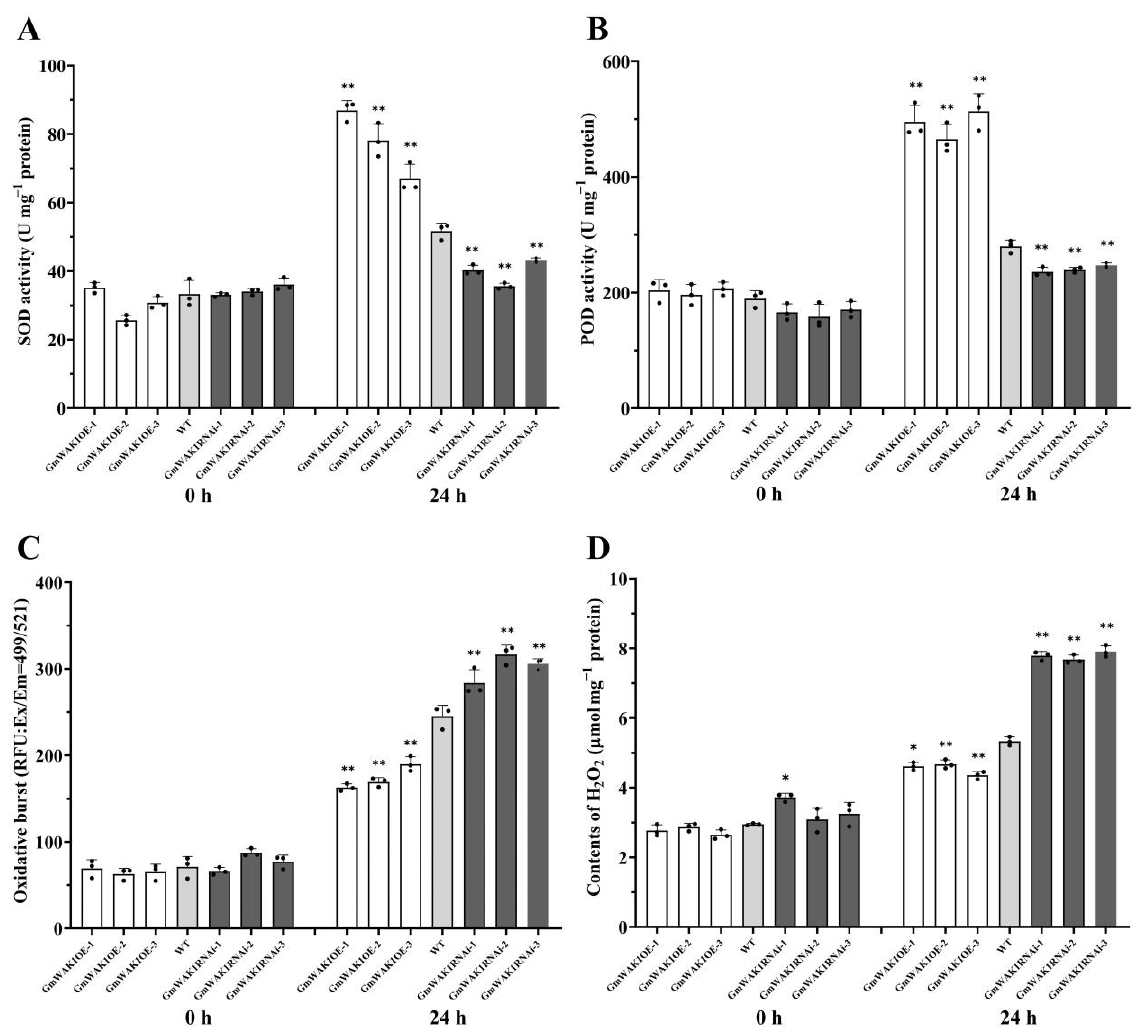
Figure 5. Activities of superoxide dismutase (SOD) ( A ), peroxidase (POD) ( B ), reactive oxygen spe- cies (ROS) ( C ), and hydrogen peroxide (H 2 O 2 ) ( D ) accumulation. Relative activity of POD and SOD and relative contents of total ROS and H 2 O 2 in transgenic soybean plants and mock-treated WT plants at 0 and 24 h after P. sojae infection. Three biological replicates, each with three technical replicates; * p < 0.05, ** p < 0.01, Student’s t test; error bars indicate standard